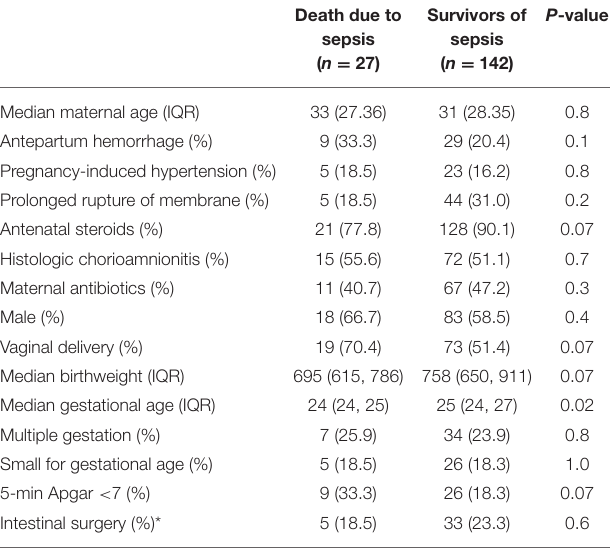
TABLE 1 | Perinatal characteristics of preterm VLBW infants with late onset sepsis ( n = 169).